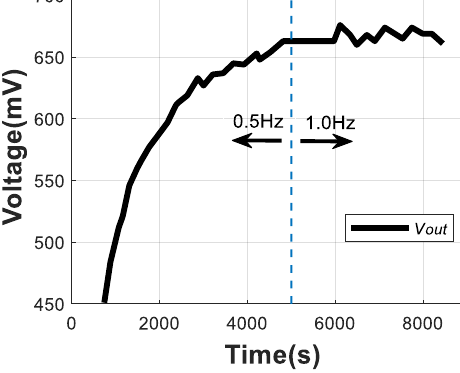
Figure 10. Time series of outputs of detection circuit .